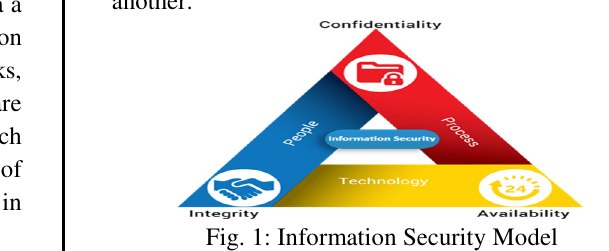
Fig. 1. Confidentiality means that information will not be disclosed to unauthorized individuals. Integrity refers to the fact that the state of data must remain the same when it is transferred from one system to another.